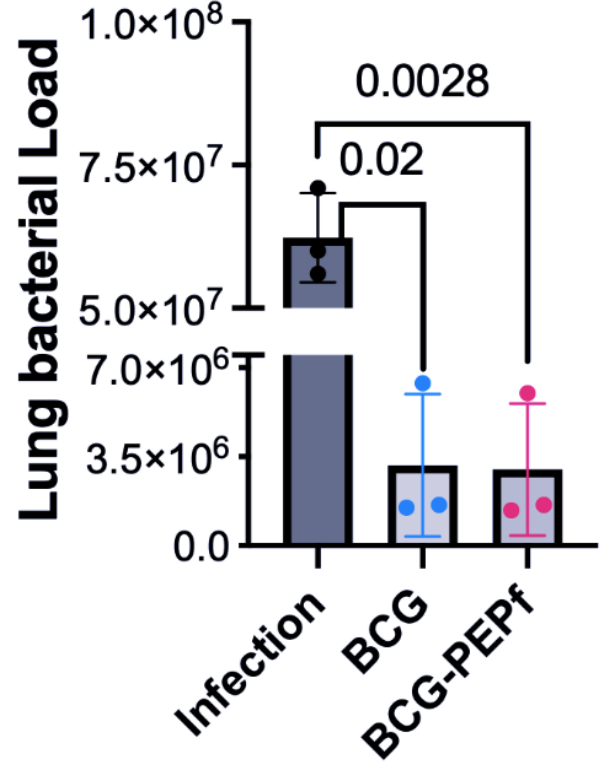
Figure 5. Protection against Mtb challenge after live vaccine immunizations. Forty-five days after challenging using Mtb, following immunization with BCG or BCG-PEPf, the mycobacterial loads in the lungs of the infected animals were determined (N = 4 mice per group). The bacterial loads in the vaccinated animal lungs were at least one log lower compared to unvaccinated animals. The protection conferred by BCG and recombinant BCG vaccines were similar. Data shown (circles) represent the CFUs for each animal, and the bar shows the average (with SD) for each group. The results represent one of two independent